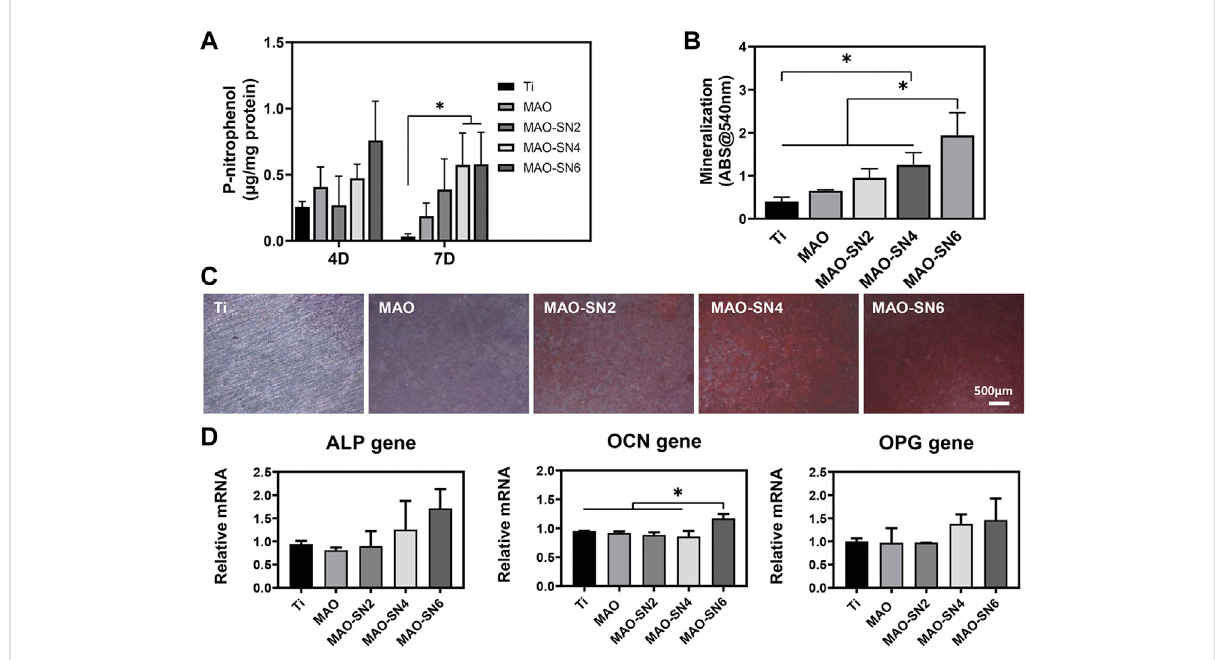
FIGURE 6 Quantitativestatistics ofALP activity at4 and 7d (A) and mineralization (B) . ALP activity at14 d. (C) Representative Alizarin Red S staining images at 14 d. (D) Relative expression levels of ALP , OCN , and OPG by MC3T3-E1 cells after 7 d. * p <